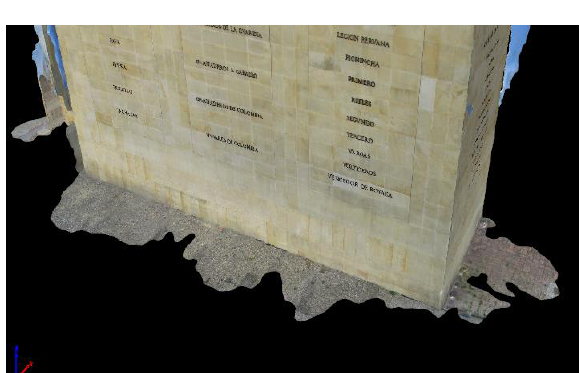
Figure 14: Result of 3D reconstruction from capturing images from the surface bottom view of the monument.